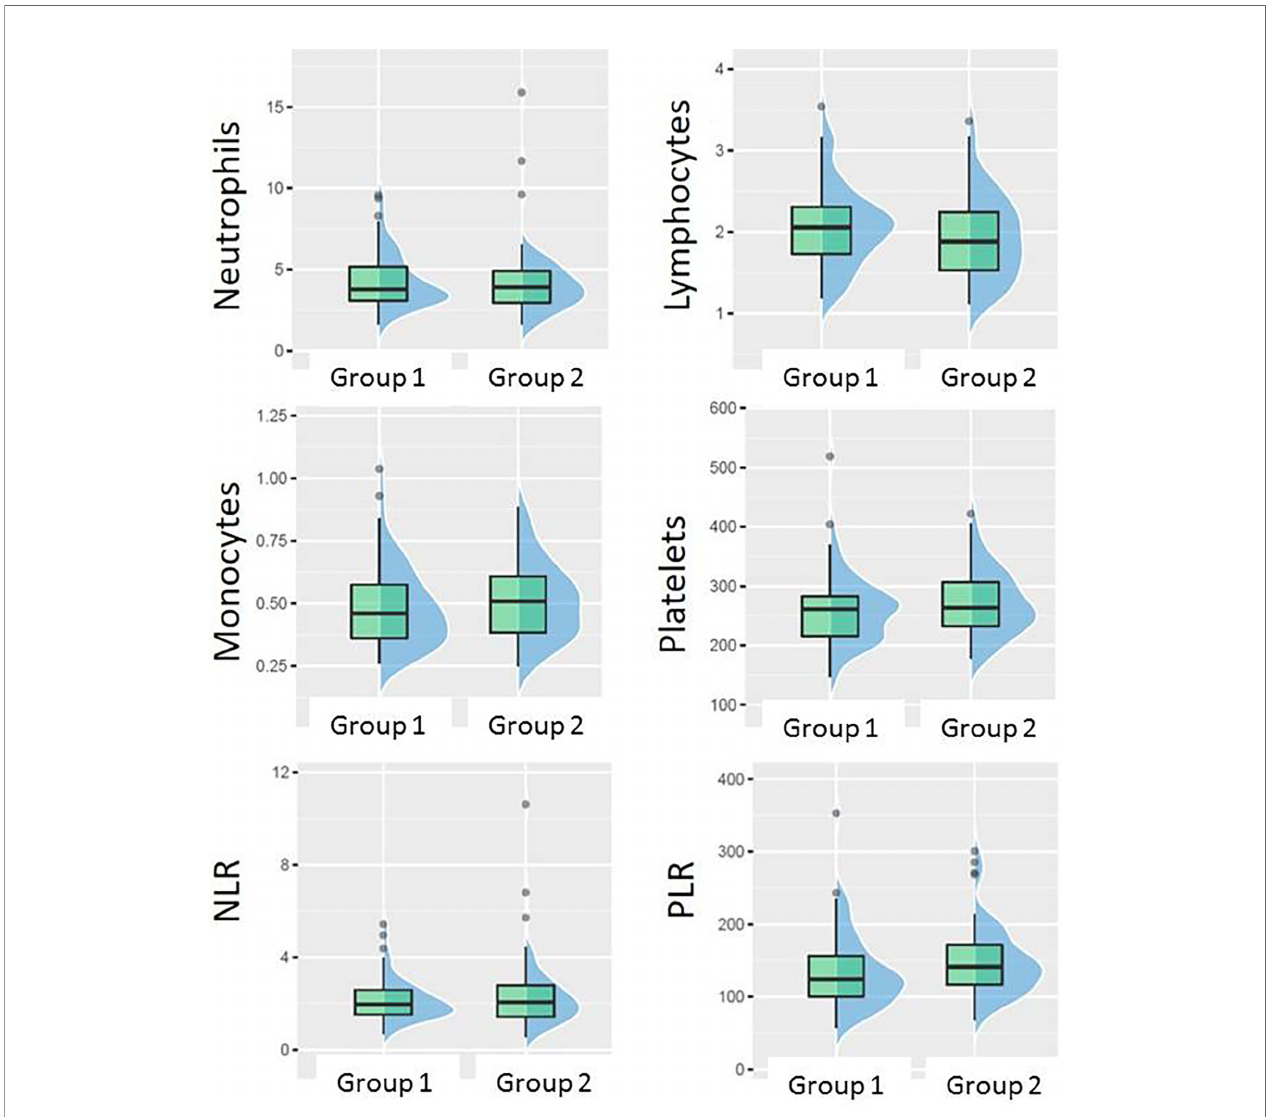
FIGURE 4 | Boxplots showing the difference between Group 1 (pCR + small residual disease) and Group 2 (larger residual disease) in different blood counts or their ratios at